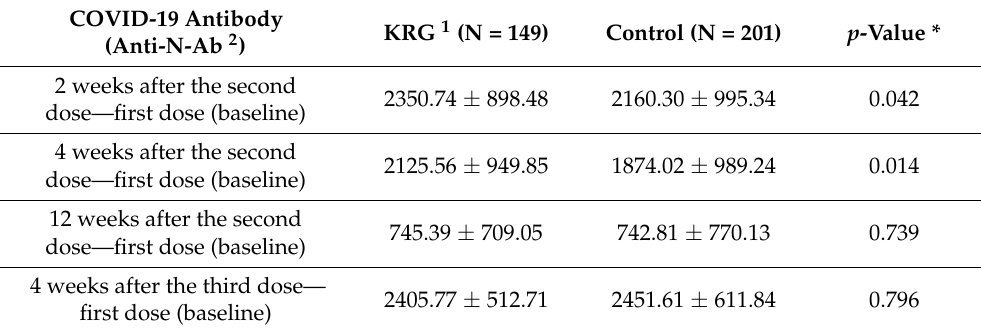
Table 3. COVID-19 antibody after vaccination in the KRG and control